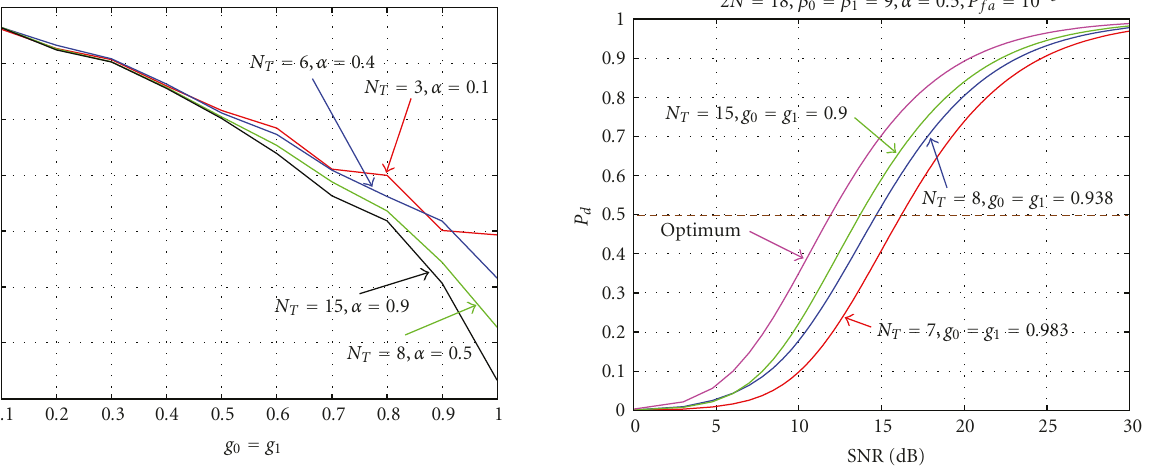
Figure 8: Comparison of P d for SOS I with di ff erent N T and g 0 = g 1 (2 N = 18 and P fa = 10 − 5